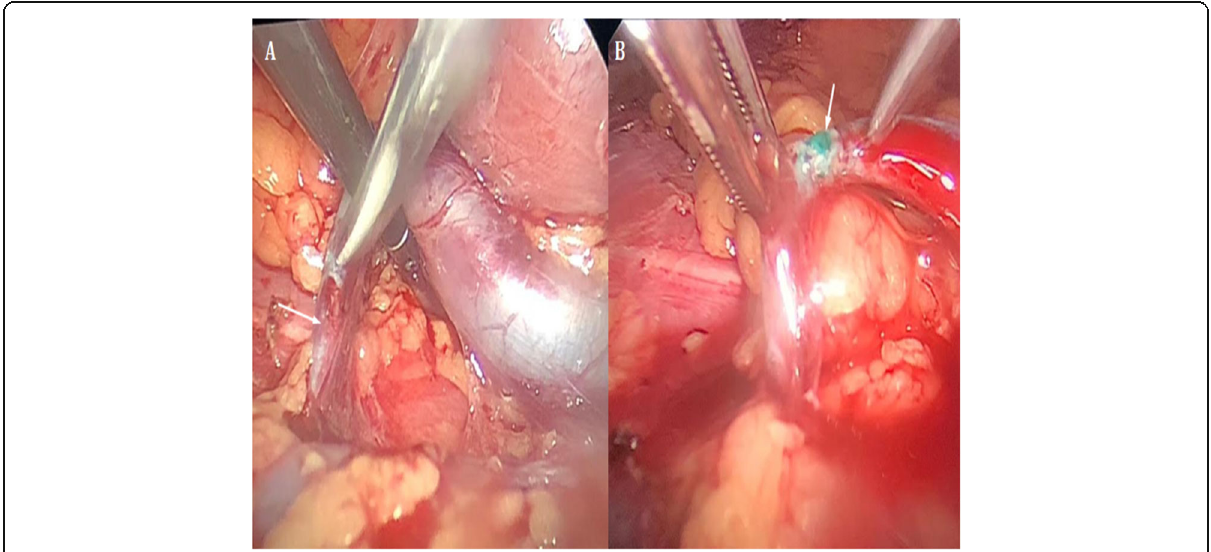
Fig. 12 Same patient as in Figs. 10 and 11 with retrocaval ureter. Intraoperative images show the resection ( a ) and re-anastomosis ( b ) of the aperistaltic retrocaval segment of the ureter, anterior to the